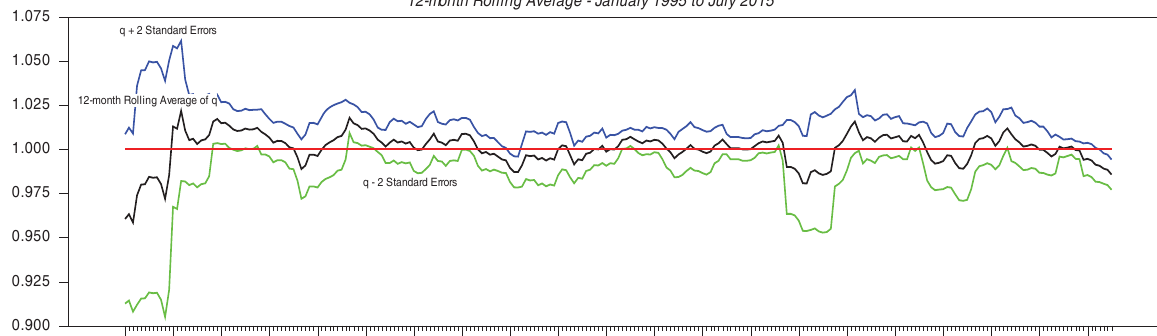
Fig. 12. Mexican peso-U.S. dollar real exchange